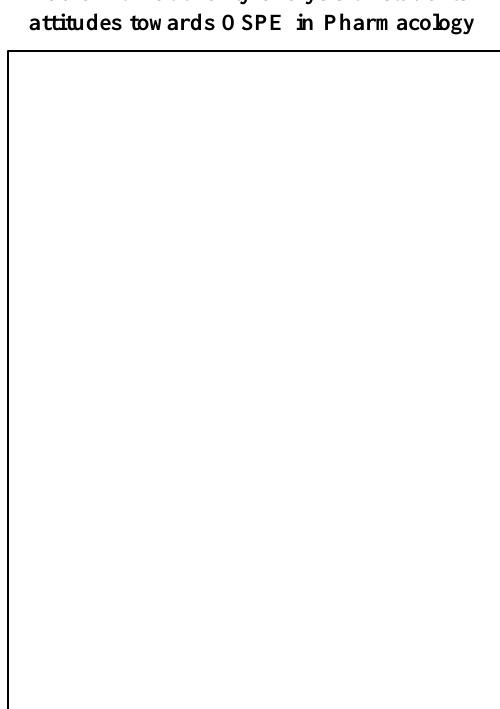
Table 4 : Nationality analysis of students' attitudes towards OSPE in